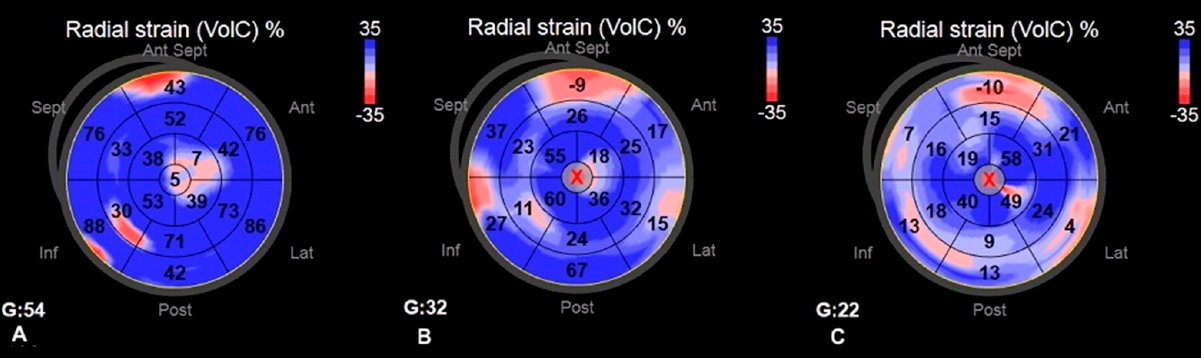
Figure 5. The example of 3D LV radial strain measurements—the bull eye representation of a healthy person ( A ); HCM patient without FA diagnosis ( B ); HCM patient with FA diagnosis ( C ).